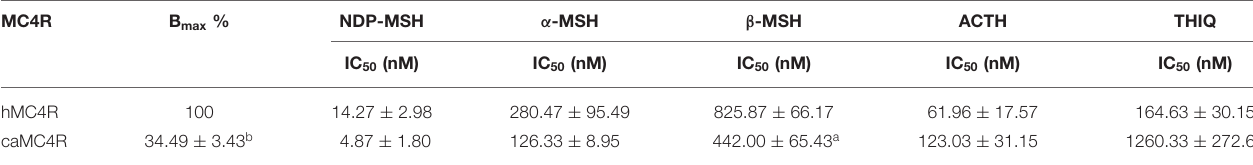
Results are expressed as the mean ± SEM of at least three independent experiments. Human MC4R was used for comparison. a Significantly different from the parameter of hMC4R, P < 0.05. b Significantly different from the parameter of hMC4R, P < 0.001.